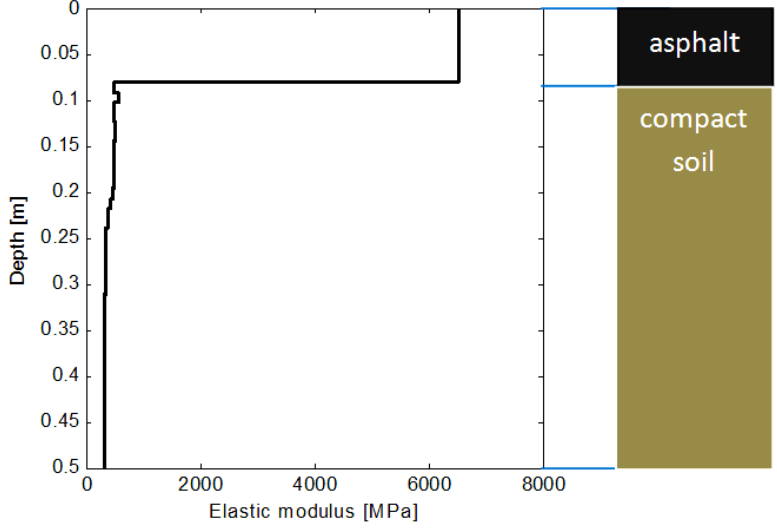
Figure 16. Estimated elastic modulus profile at parking lot